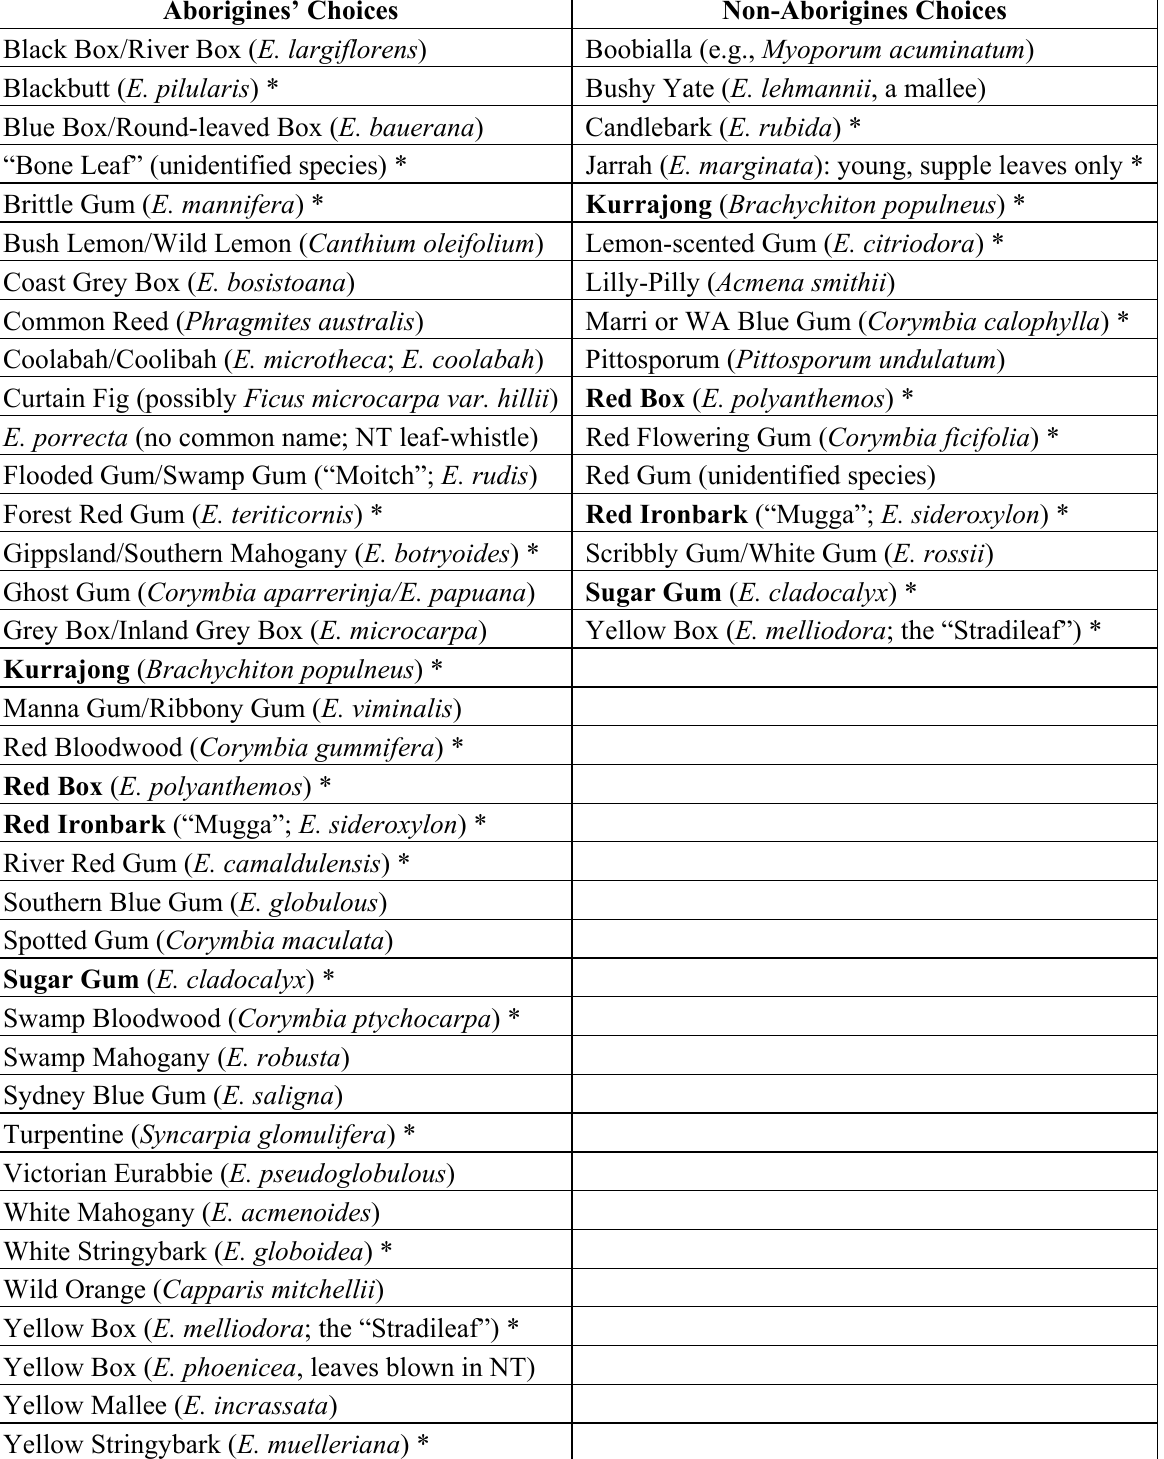
Table 1. Comparative typology of native Australian leaf